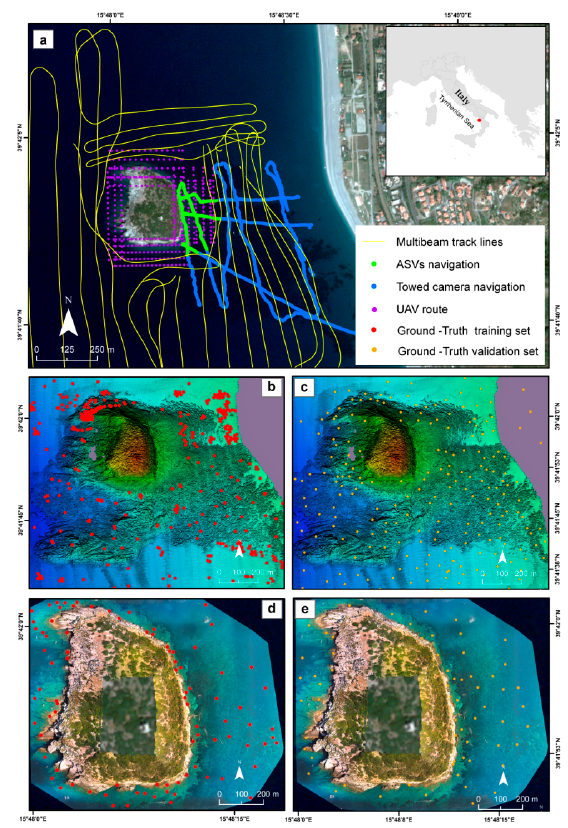
Figure 3. ( a ) Study Area Site of Community Importance (SCI) Isola di Cirella located in the southern Tyrrhenian Sea. Track lines of Multibeam bathymetry, UAV, Underwater Towed Video Camera Systems and Autonomous Surface Vehicles (ASVs) surveys. Ground-truth training and validation sampling set for classification step: ( b , c ) shallow water area; ( d , e ) very shallow water area.